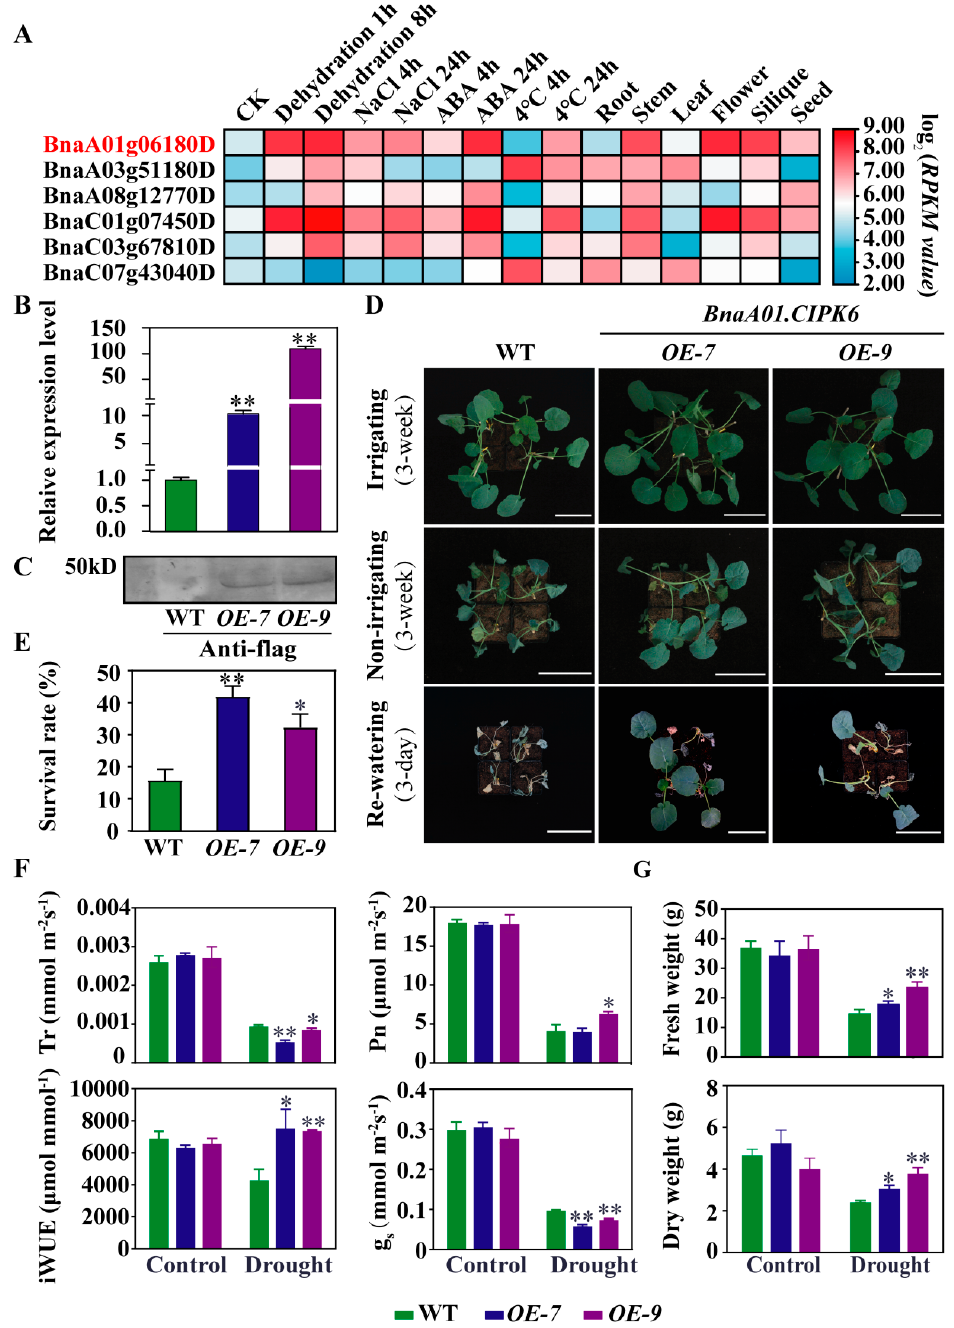
Figure 5. Over-expression of BnaA01.CIPK6 confers drought tolerance in B. napus . ( A ) Expression pattern analysis of BnCIPK6. ( B ) Relative expression level of BnaA01.CIPK6 gene in two BnaA01.CIPK6- overexpression lines, OE-7 and OE-9 . ( C ) Western blot analysis of BnaA01.CIPK6 gene expression in BnaA01.CIPK6- overexpression ( OE-7 and OE-9 ). ( D ) The response of BnaA01.CIPK6- overexpression plants ( OE-7 and OE-9 ) to drought stress. Bar = 10 cm. ( E ) Survival rate of BnaA01.CIPK6- overexpression lines ( OE-7 and OE-9 ) under drought stress. ( F ) Measurement of photosynthesis-related parameters of BnaA01.CIPK6- overexpression lines ( OE-7 and OE-9 ) under drought stress. ( G ) Aboveground biomass of BnaA01.CIPK6- overexpression lines ( OE-7 and OE-9 ) under drought stress. The data are the means ± standard deviation ( n = 4). Statistical significance was assayed by Student’s t -test. * p < 0.05, ** p <